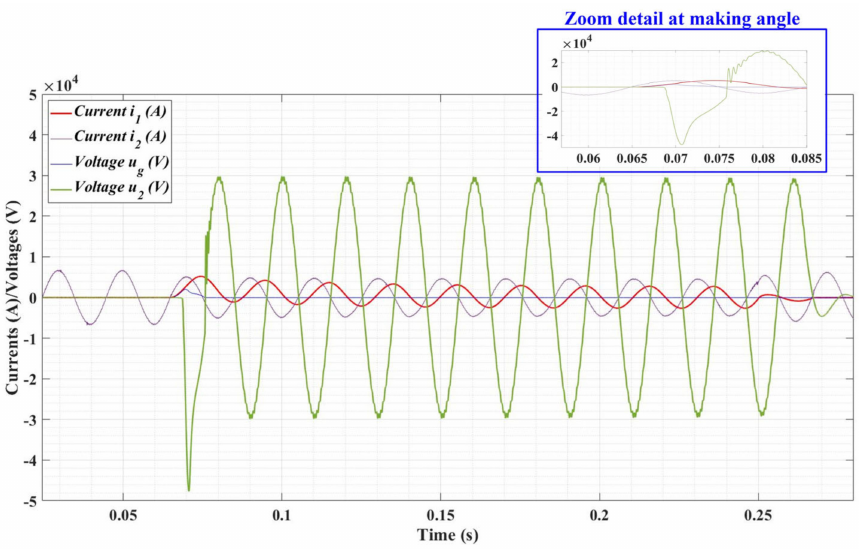
Figure 19. Simulated oscillogram obtained for I 2 with detail on making